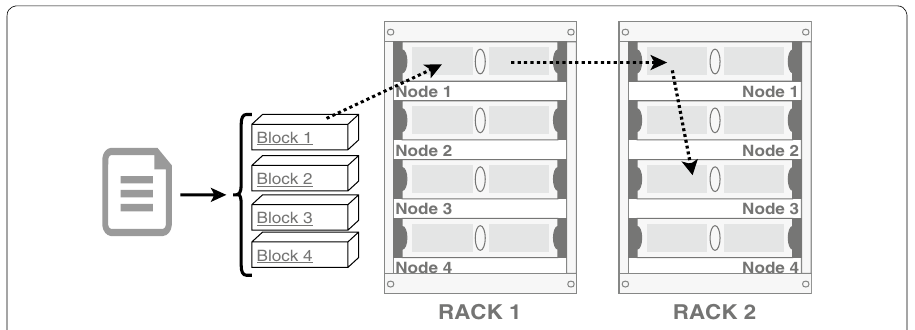
Fig. 1 Data uploading to the